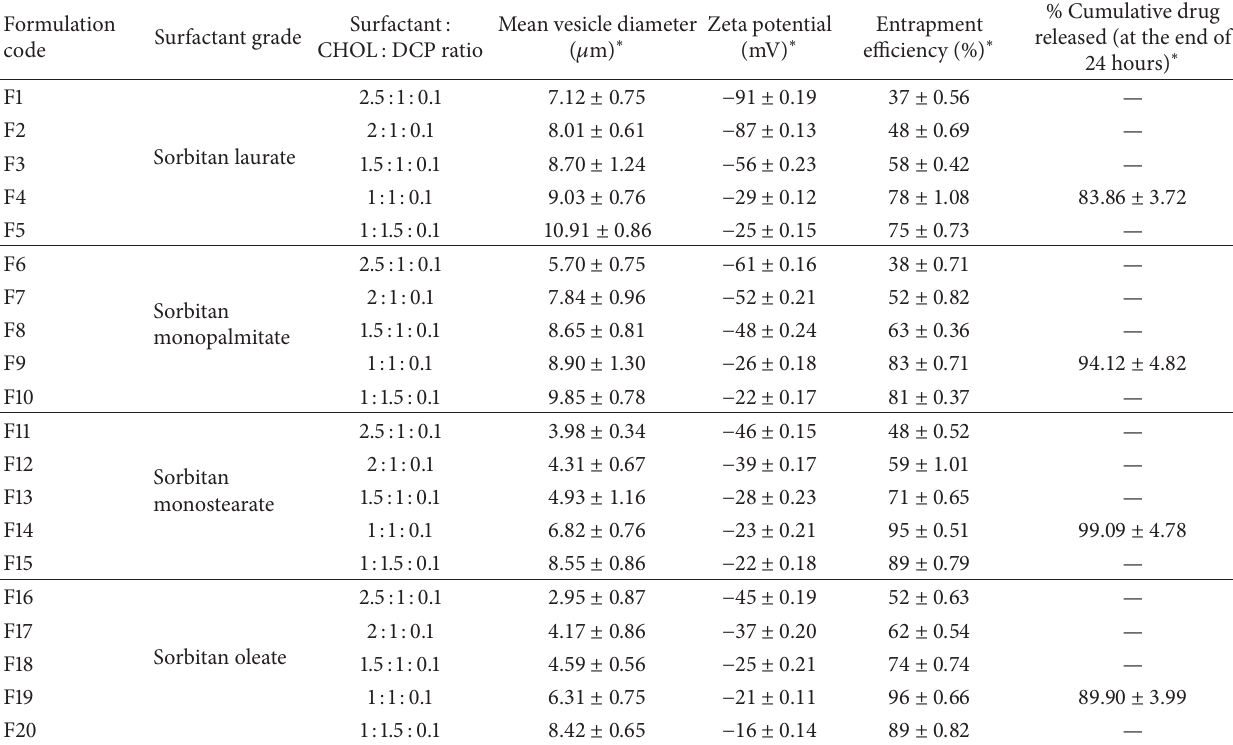
Table 3: Composition and characterization of niosomal formulations.